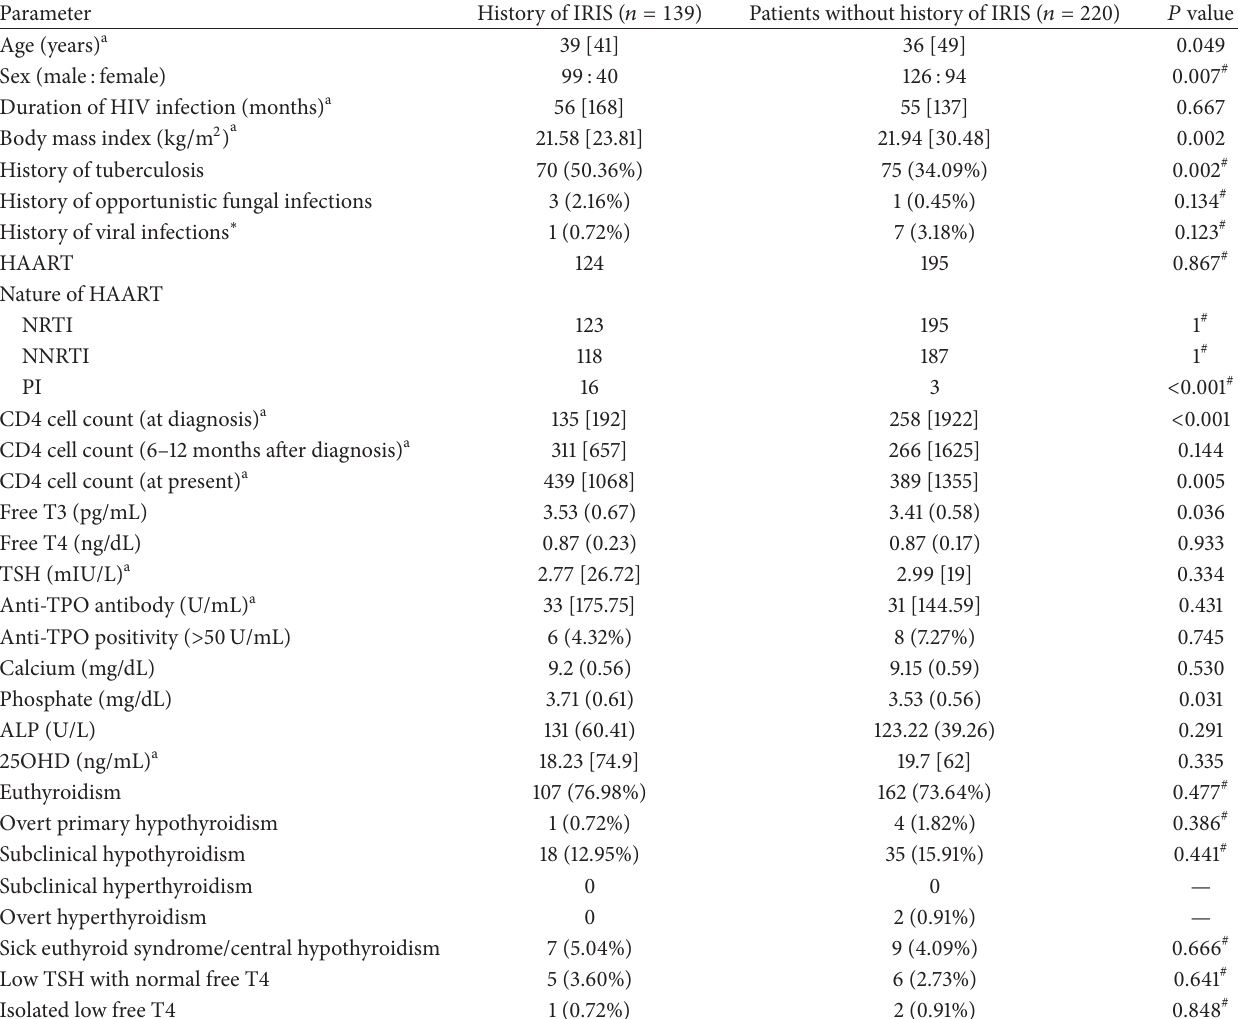
Table 2: Thyroid function profile of patients with immune reconstitution activation syndrome (IRIS) as compared to those without. Parameter History of IRIS ( 𝑛 = 139